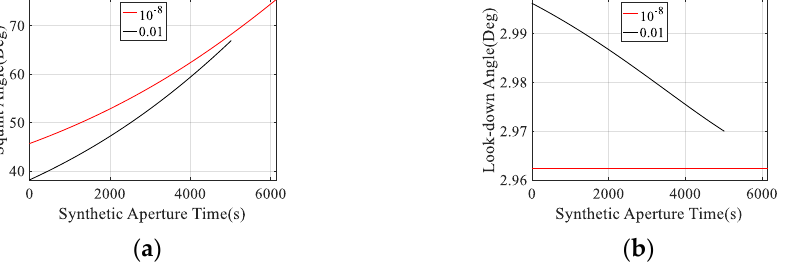
Figure 4. Variations of the RLS during the synthetic aperture time. ( a ) The eccentricity is 10 − 8 ; ( b ) the eccentricity is 0.01.